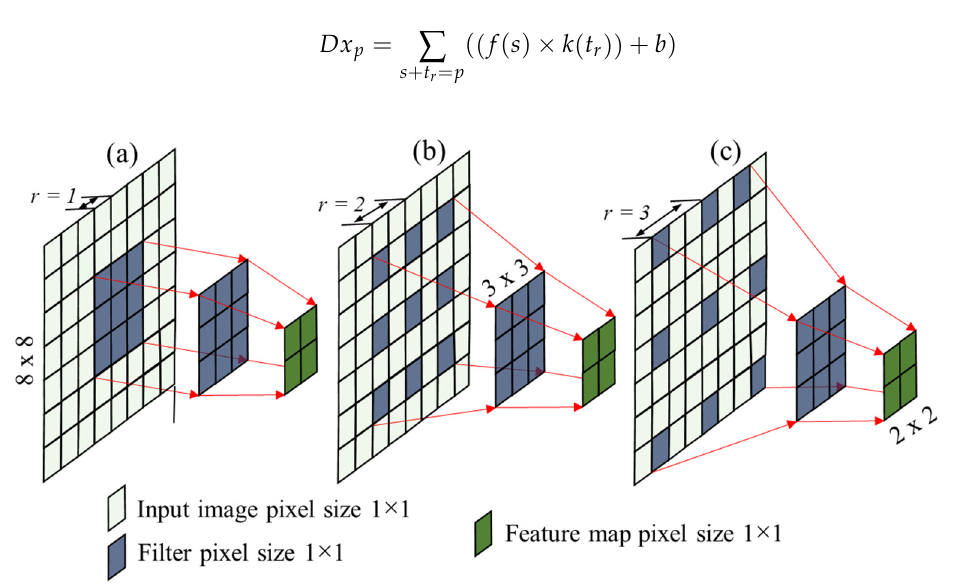
Figure 4. Examples of convolution: ( a ) standard convolution and ( b , c ) dilated convolution.